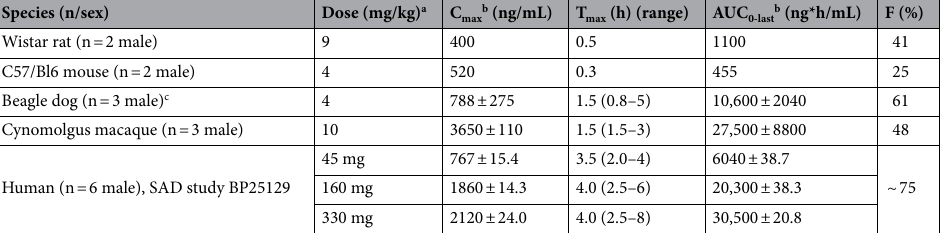
Table 1. Summary of mean pharmacokinetic parameters of basmisanil following single oral dosing across species. AUC area under the concentration–time curve, C ma x maximum plasma concentration, SAD single ascending dose, F bioavailability (%), T max median time to reach maximum concentration. a Dose is expressed as mg/kg, except for humans where dose is expressed as mg. b For dog and cynomolgus macaque: ± standard deviation; for human: ± percent coefficient of variation. c Basmisanil administered as capsule in dog, as microsuspension in rat, mouse and cynomolgus macaque, and as tablet formulation in